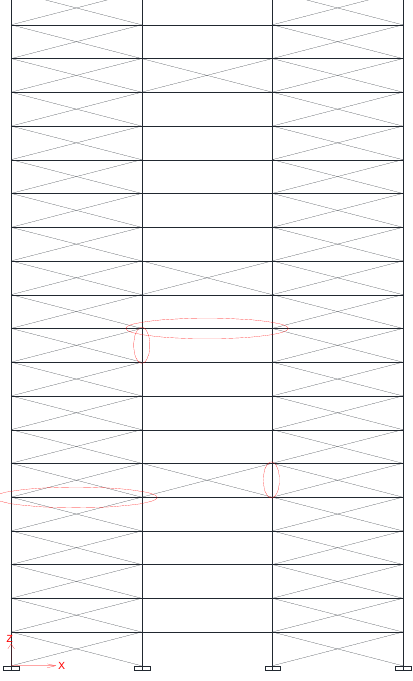
Figure 26. Schematic view of the Step 2 damaged 20-story frame (by removing one beam and one column on the tenth floor in addition to removing one beam and one column on the fifth floor). The beam and column removed are shown with a circle marked in red.